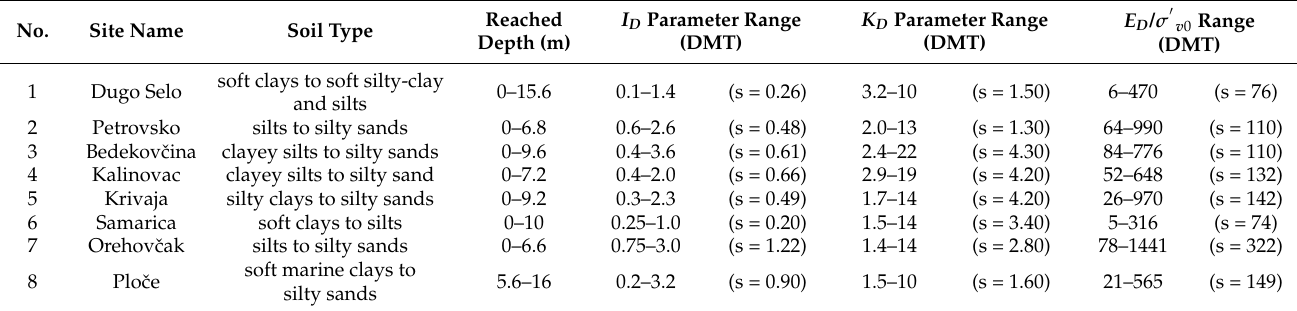
Table 2. List of study sites including measured DMT profiles details.